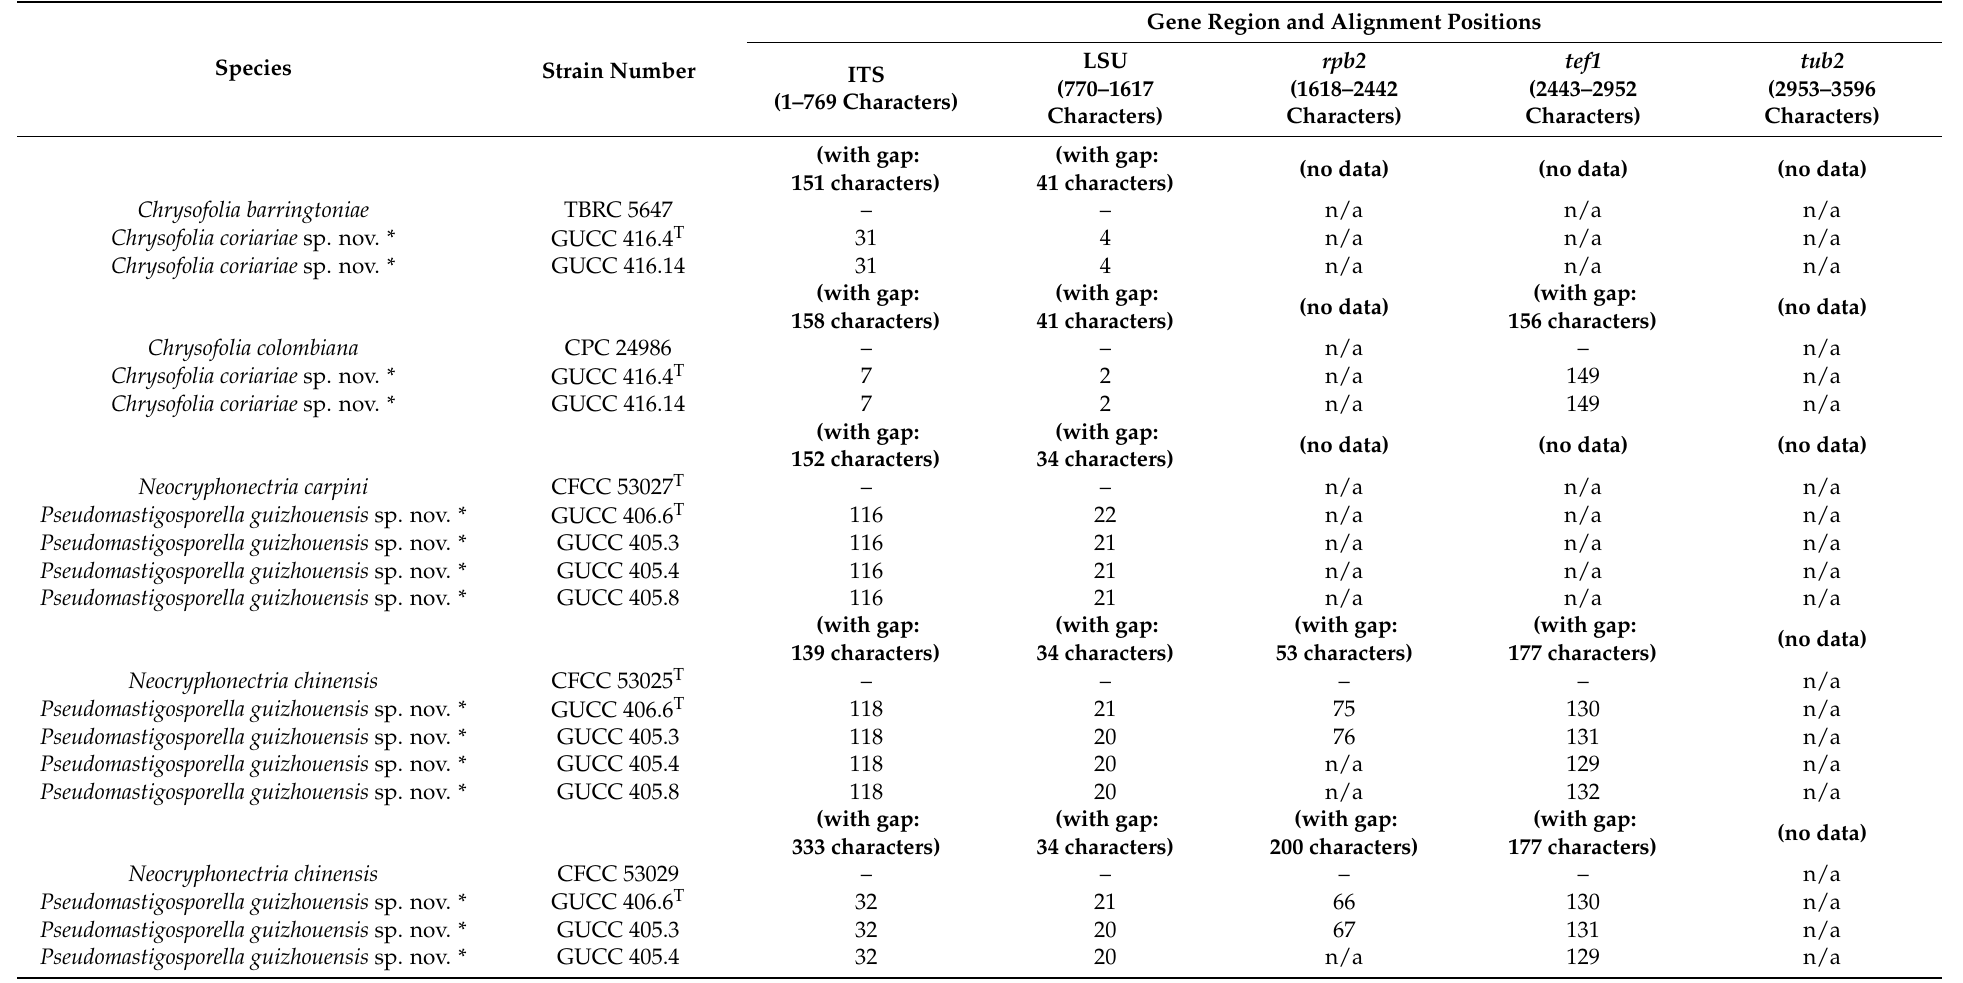
Table 7. DNA base differences between our strains and related taxa in the five-locus regions. Asterisks (*) denote our material. ( T ) = ex–type